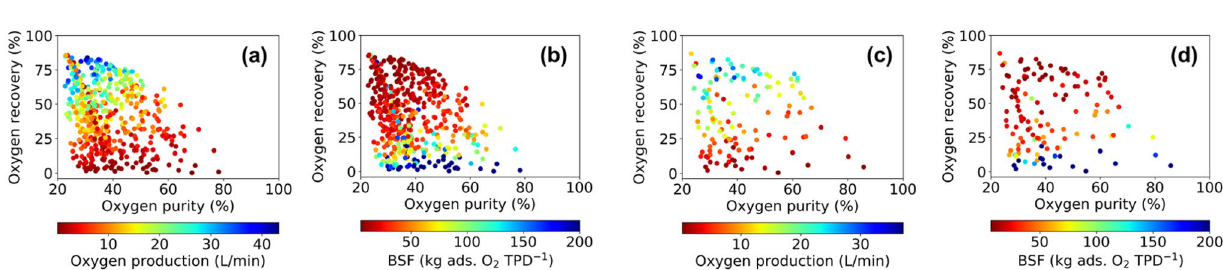
Figure 7. Process simulation data and output performance metrics for 5A zeolite. ( a , b ) PSA cycle and ( c , d ) PVSA